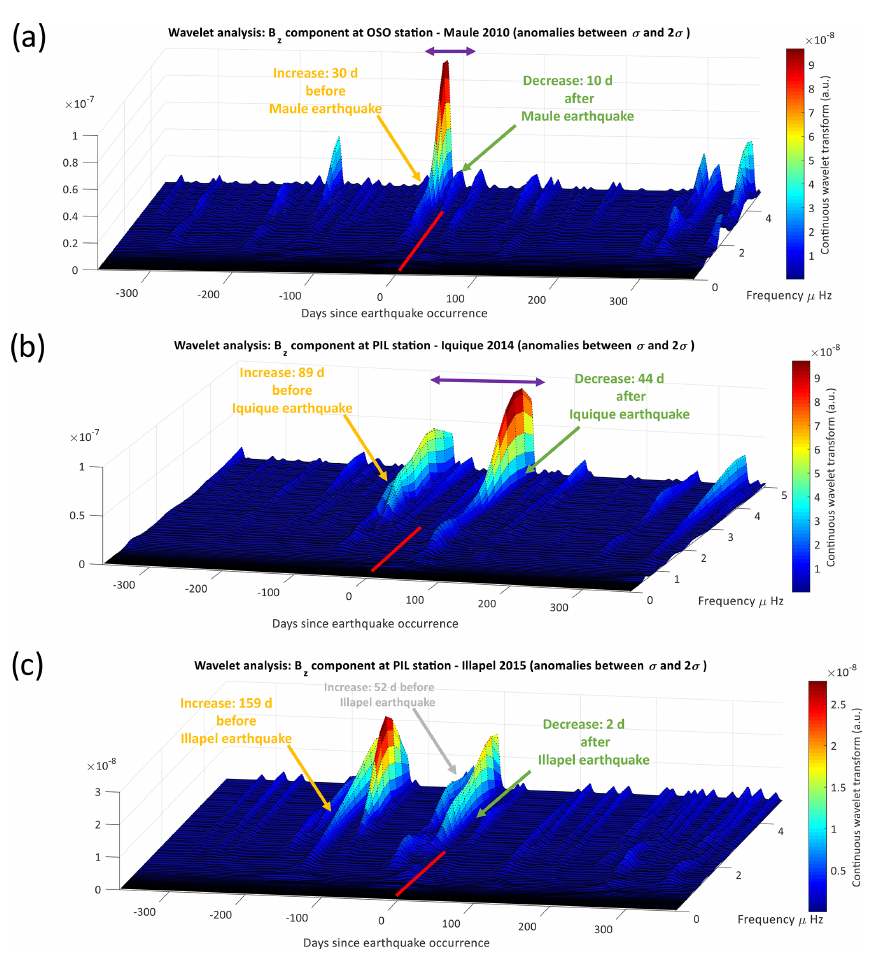
Figure 5. Wavelet for B z at OSO station is shown. These graphs are obtained by restricting the peaks considered in a band and daily average values during 2 years of measurements. The wavelet spectrum shows an increase prior to and after the Maule earthquake. Unlike the spectrogram method where it is enough to consider the anomalous peaks above a threshold, wavelet analysis is more complex to calibrate than spectrogram analysis (upper